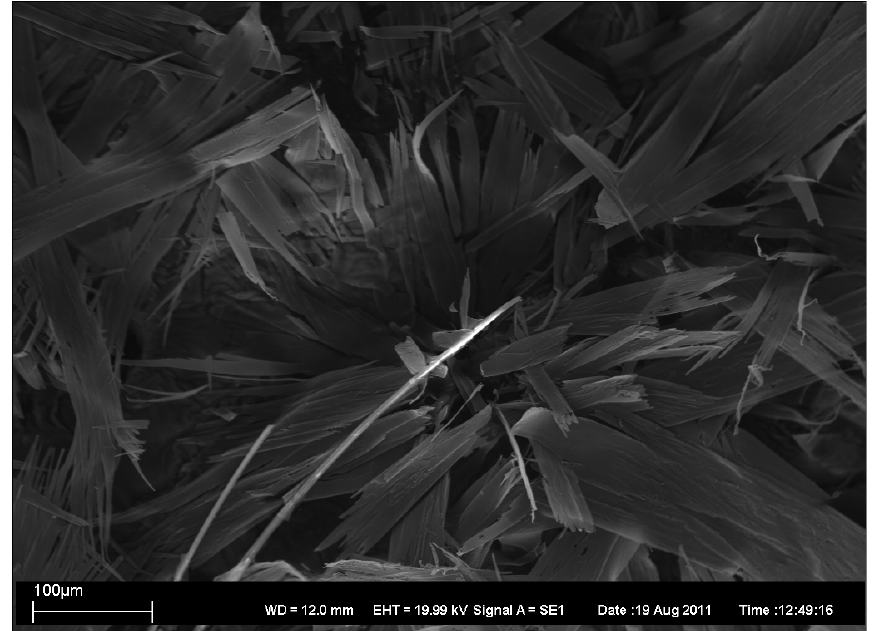
Figure 5. SEM image of xerogel from 1:1 1-PrOH/water 1%